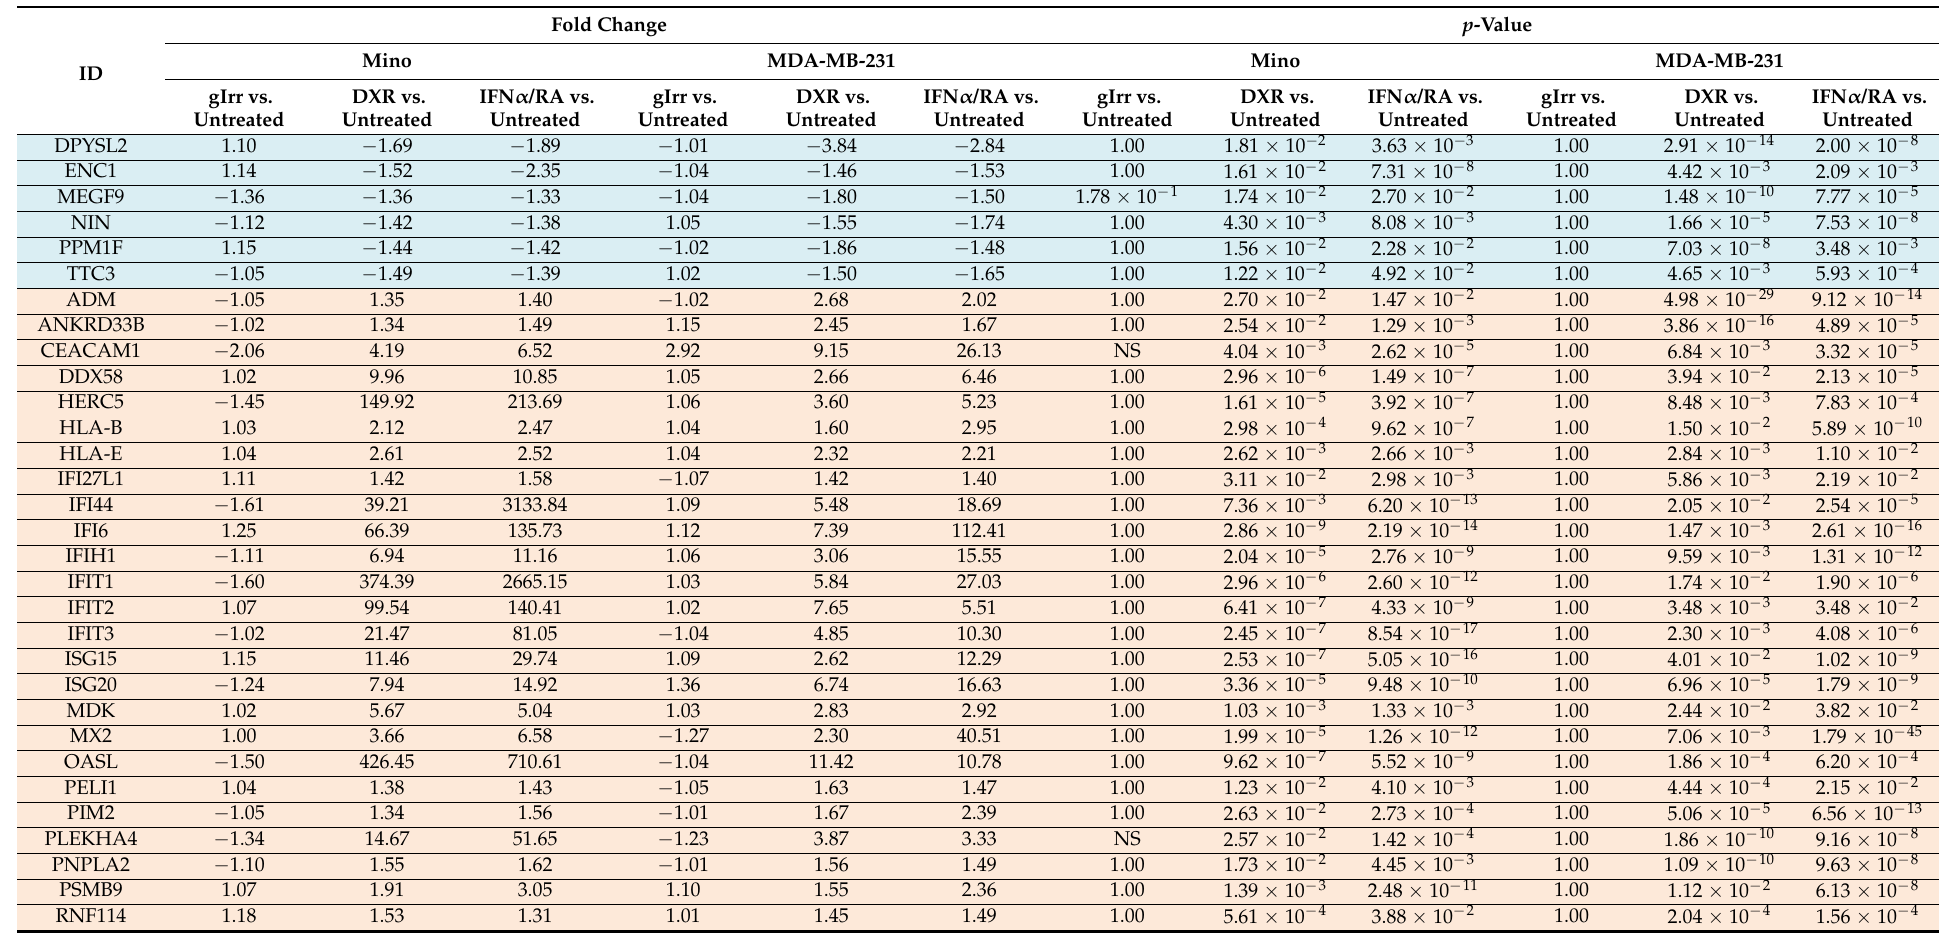
Table 2. Differentially expressed mRNAs during immunogenic cell death. mRNAs modulated by ICD inducers were identified selecting those whose expression was significantly different in DXR- or RA/IFN α -treated samples versus untreated ones (adjusted p -value ≤ 0.05, FC ≤ − 1.3 for downregulated, FC ≥ 1.3 for upregulated), but not significantly different in gamma irradiation-treated samples. Downregulated mRNAs are highlighted in blue, upregulated mRNAs are highlighted in